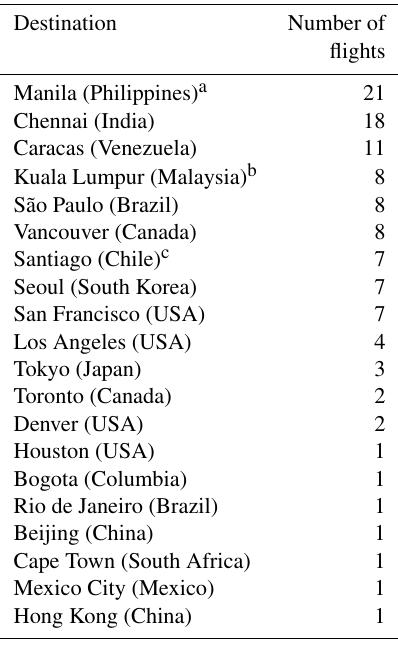
Table B1. Frequency of occurrence of the destinations in the CARIBIC flights used for the climatologies in Sect. 7. The total number of different flights is